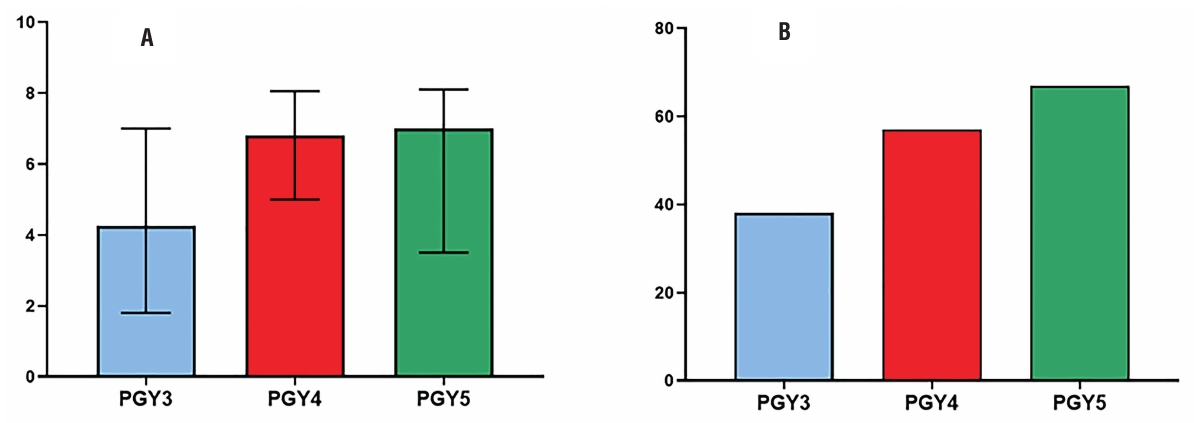
Figure 1-a) Damage to urological learning in 2020 as estimated by residents from postgraduate years 3, 4 and 5 and b) Percentage of residents from postgraduate years 3, 4 and 5 who favor extending the residency